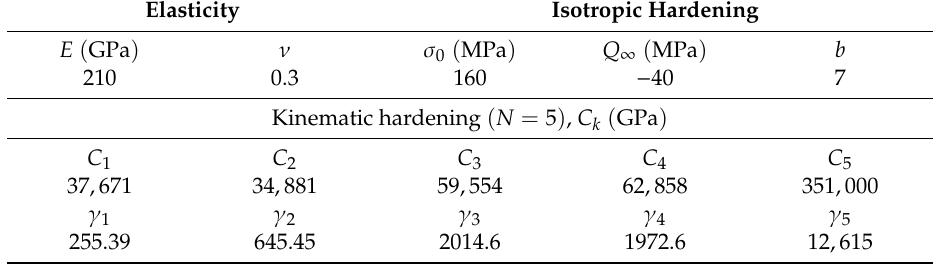
Table 3. Finite element analysis parameters of pearlite.